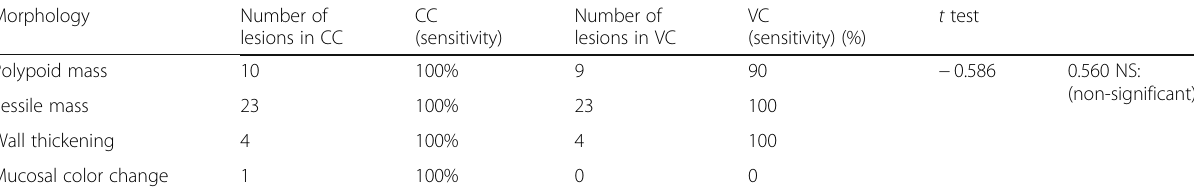
Table 9 Comparison between conventional cystoscopy (CC) and virtual cystoscopy (VC) regarding the morphological description of the lesions Morphology